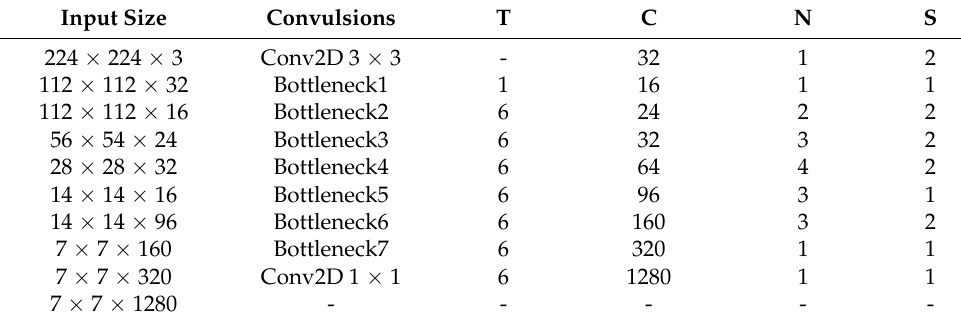
Table 1. Contraction processing of our Mobile-Unet.